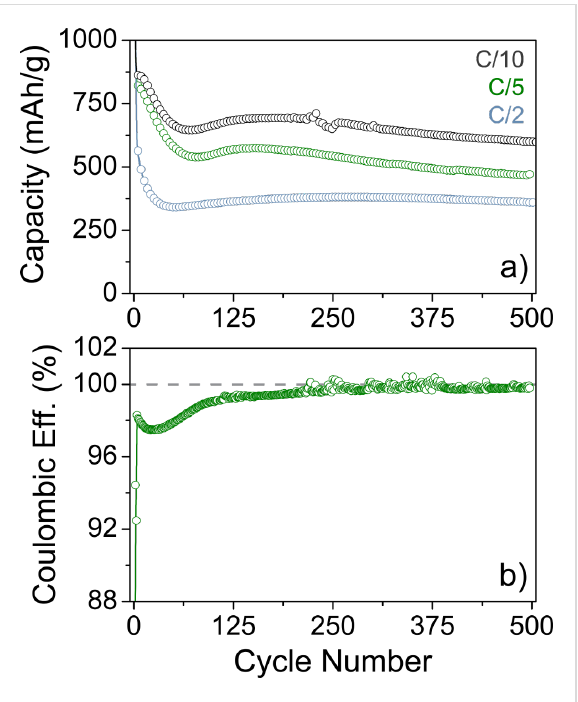
Figure 9: (a) Long-term cycling performance of ZFO nanoparticle elec- trodes in Li half-cells at C/10 (black), C/5 (green) and C/2 (blue). (b) Coulombic efficiency of the cell cycled at C/5. The dashed line in (b) indicates 100% efficiency. After about 220 cycles, signs of dendrite growth are visible in the